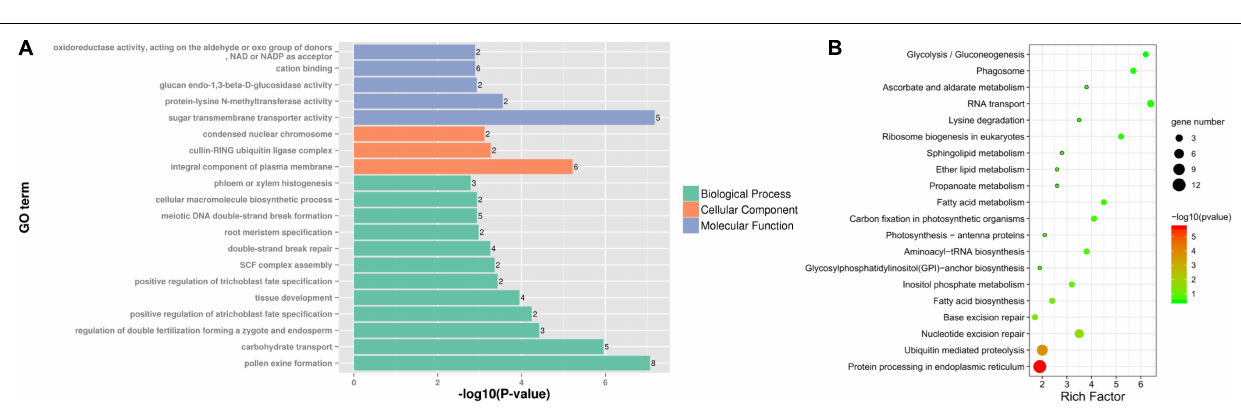
FIGURE 7 | KEGG pathway annotation of differentially expressed genes (DEGs). Top 20 enriched KEGG pathways for (A) upregulated and (B) downregulated DEGs between fertile and sterile buds. The rich factor is the ratio of the number of DEGs to the total number of genes in each pathway. The color and size of the dots indicate the P -value and the number of DEGs mapped to the pathway, respectively.